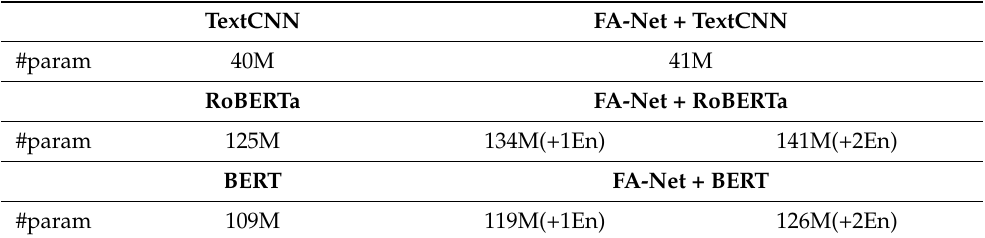
Table 2. Comparison of total parameters between base models and our models: +1En means the auxiliary network has one transformer encoder, and +2En means two transformer encoders exist in the auxiliary